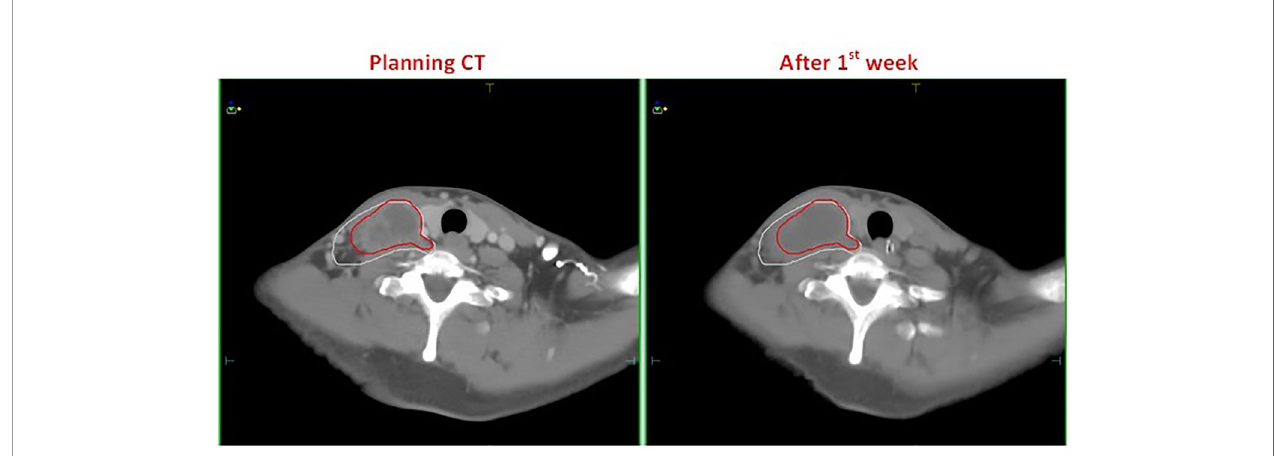
FIGURE 1 | A patient with esophageal cancer who developed edema after the fi rst week of radiotherapy. The left and right fi gures are the planning CT image and the repeat CT image after the fi rst week of radiotherapy, respectively. The red line is the GTV contour at the planning stage, and the white line is the GTV contour after the fi rst week of